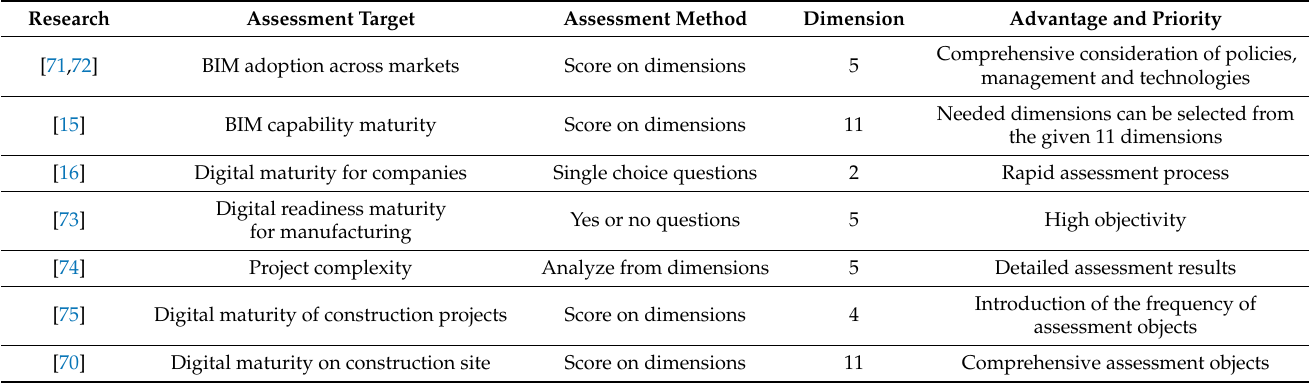
Table 2. Maturity assessment systems in other informational, digital or intelligent